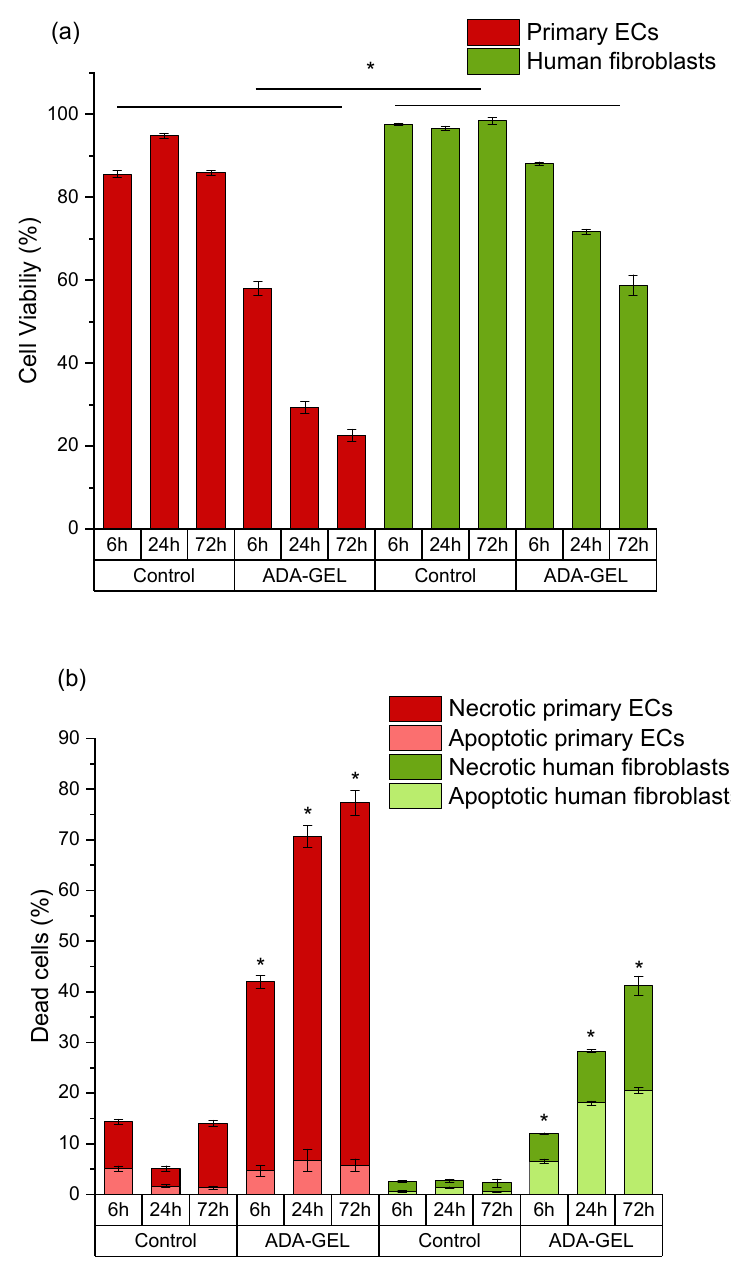
Figure 5. Time-dependent comparison of primary ECs and fibroblasts grown in ADA-GEL. ( a ) Cell viability (DiI-positive cells); ( b ) apoptotic populations in total death cluster (DiI-negative, PI-negative staining) and necrotic populations in total death cluster (DiI-negative, PI-positive staining). Control: cells with DCFH-DA grown on plastic. * p < 0.05 indicates significant differences between the groups in cell viability ( a ) and number of necrotic cells ( b ).